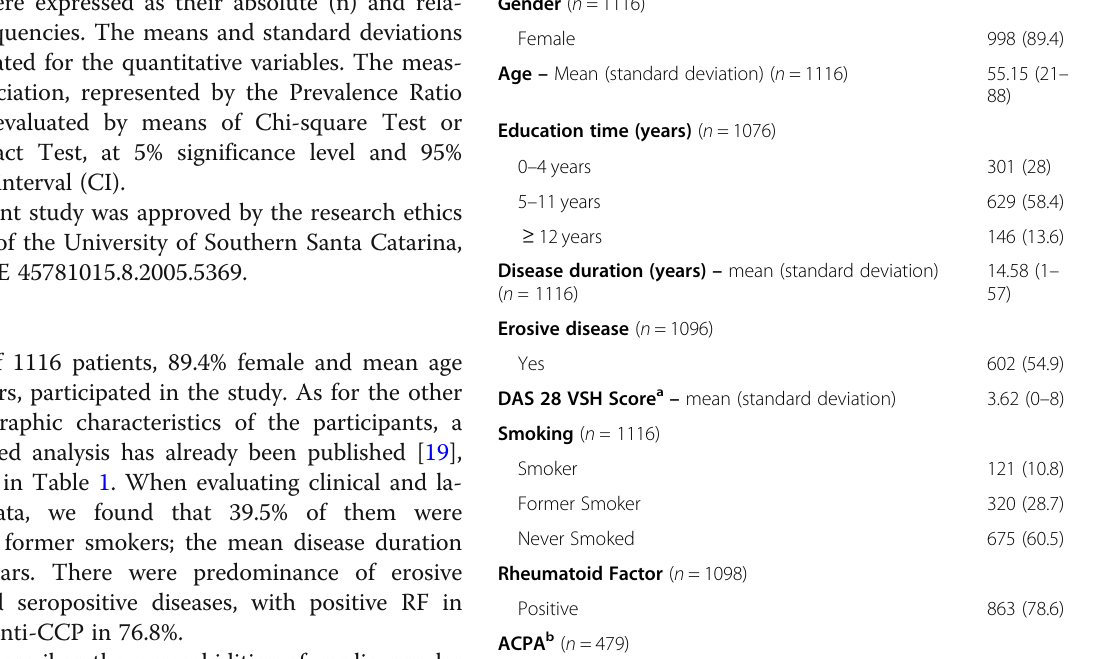
Table 1 Sociodemographic, clinical and laboratory characteristics of Rheumatoid Arthritis patients of the REAL study [19] Variables